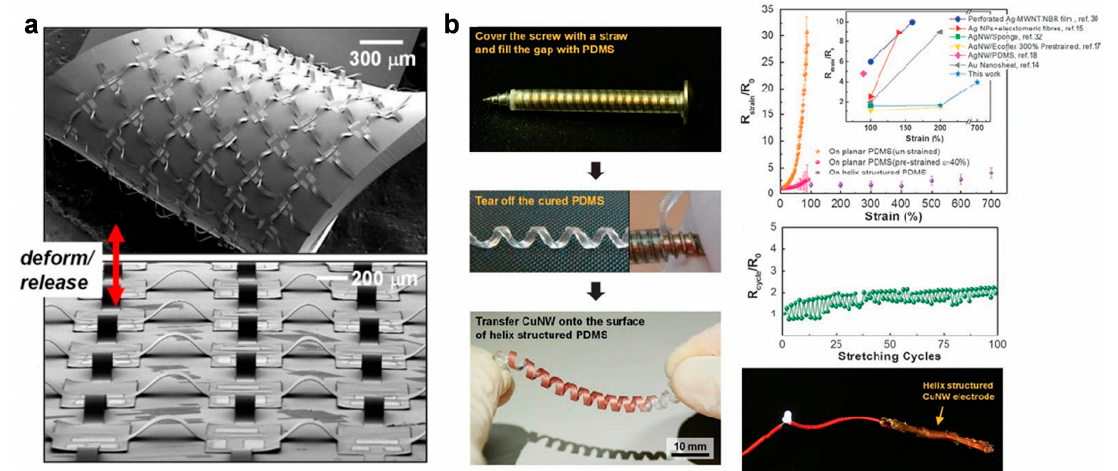
Figure 2. Examples of out-of-plane strcutres with high stretchability: ( a ) SEM images of arrays of complementary metal-oxide semiconductor (CMOS) inverters with spatially buckled bridges (Reprinted with permission from Ref. [29] Copyright 2008 National Academy of Sciences); and ( b ) helical-structured copper nanowire (CuNW)-based electrodes (Reprinted with permission from Ref. [41] Copyright 2014 Nature Publishing Group).